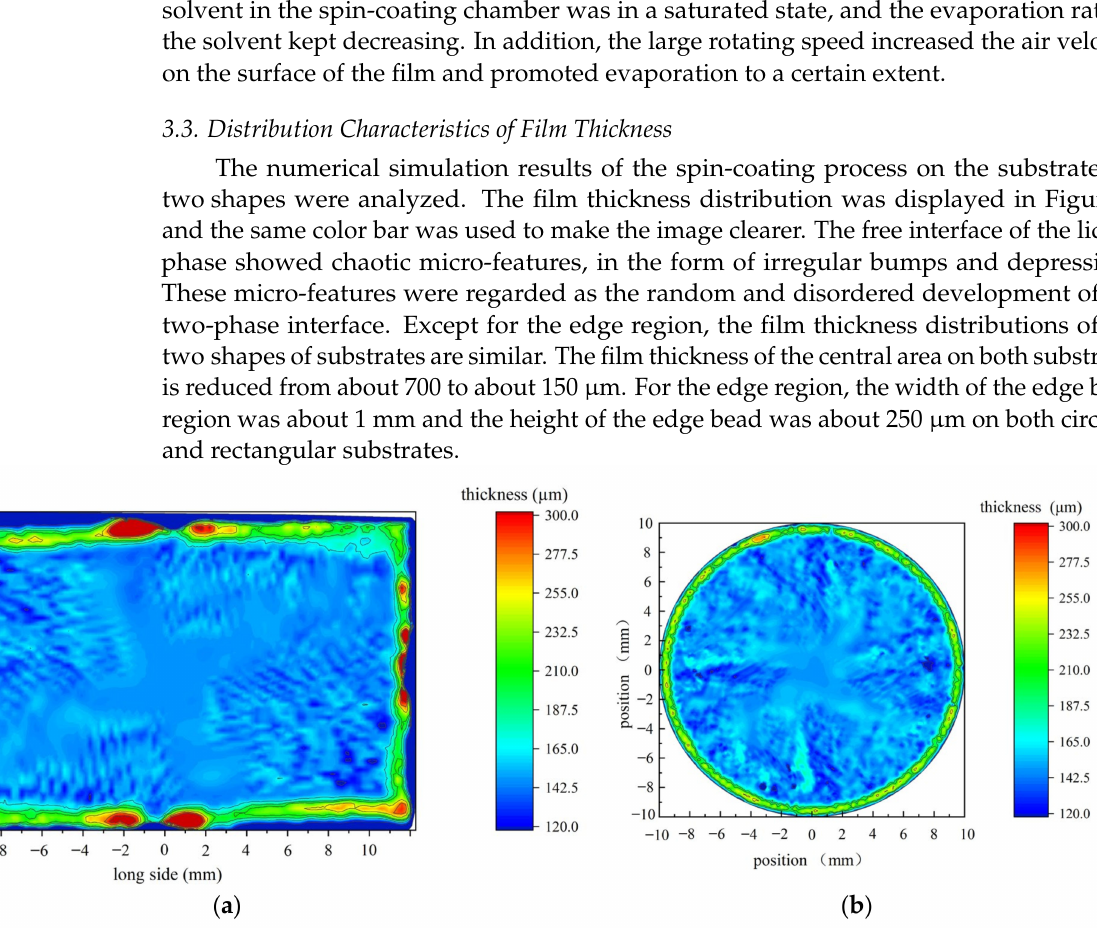
Figure 7. Final film thickness distribution in the spin-coating simulation process: ( a ) Numerical simulation of the thickness distribution of the coating film on the rectangular substrate; ( b ) Numerical simulation of the thickness distribution of the coating film on the circular